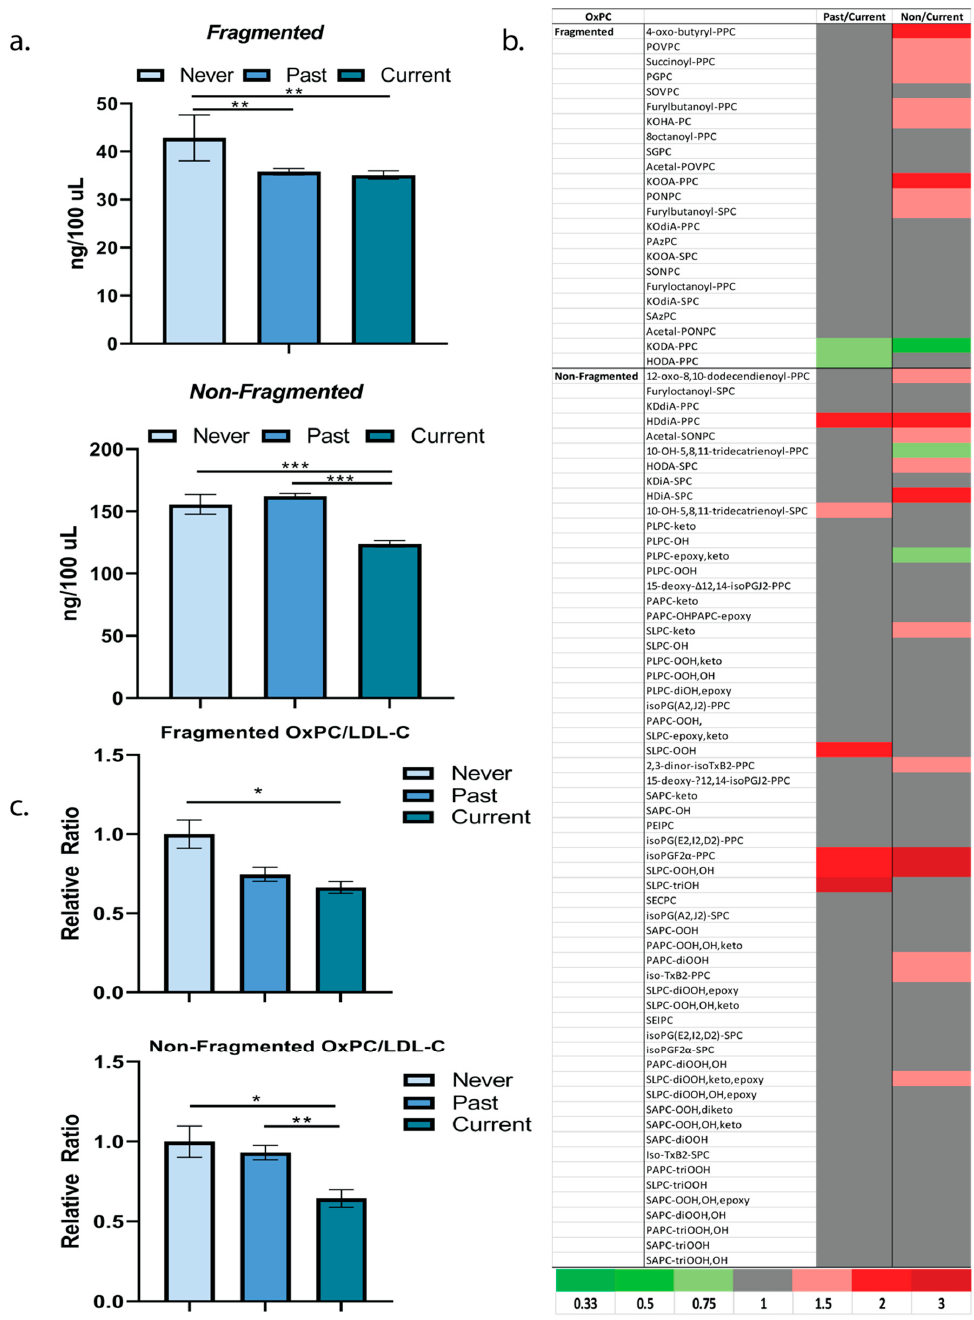
Figure 2. ( a ) Total plasma fragmented and nonfragmented OxPC concentration by smoking status in patients living with PAD. Fragmented: One way ANOVA (F = 5.19, p -value = 0.0073). Tukey’s post—hoc: **—Never Smoked vs. Past ( p = 0.0086), **—Never Smoked vs. Current ( p = 0.0064). Nonfragmented: One way ANOVA (F = 56.21, p -value < 0.0001). Tukey’s post-hoc: ***—Past Smoked vs. Current ( p < 0.0001), ***—Never Smoked vs. Current ( p < 0.0001). ( b ) Heat map representing fold differences in plasma concentrations of OxPCs by smoking status. ( c ) Plasma fragmented and nonfragmented OxPC concentrations relative to LDL-cholesterol levels by smoking status in patients living with PAD. Fragmented/LDL-C: One-Way ANOVA: (F = 3.20, p -value = 0.045). Tukey’s post- hoc: *—Never Smoked vs. Current ( p = 0.035). Nonfragmented/LDL-C: One-Way ANOVA: (F = 7.16, p -value = 0.0013). Tukey’s post-hoc: *—Never Smoked vs. Current ( p = 0.043), **—Past Smoked vs. Current ( p =